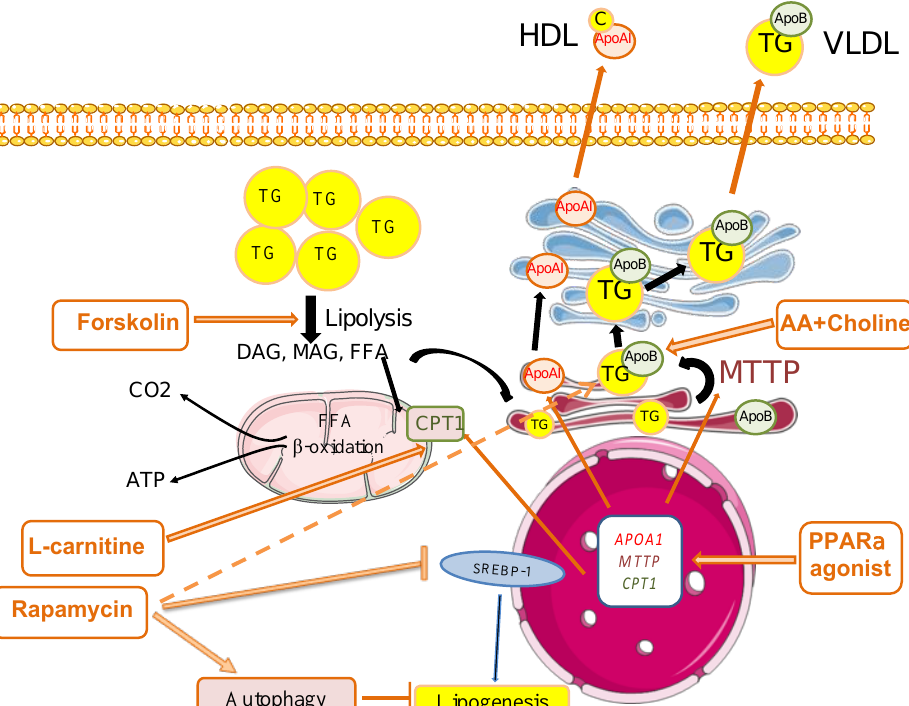
Figure 2. Main pathways and molecules used for liver defatting. Forskolin increases the phosphorylation of perilipin 5, a cell surface component of lipid droplets, and it activates the lipolysis of